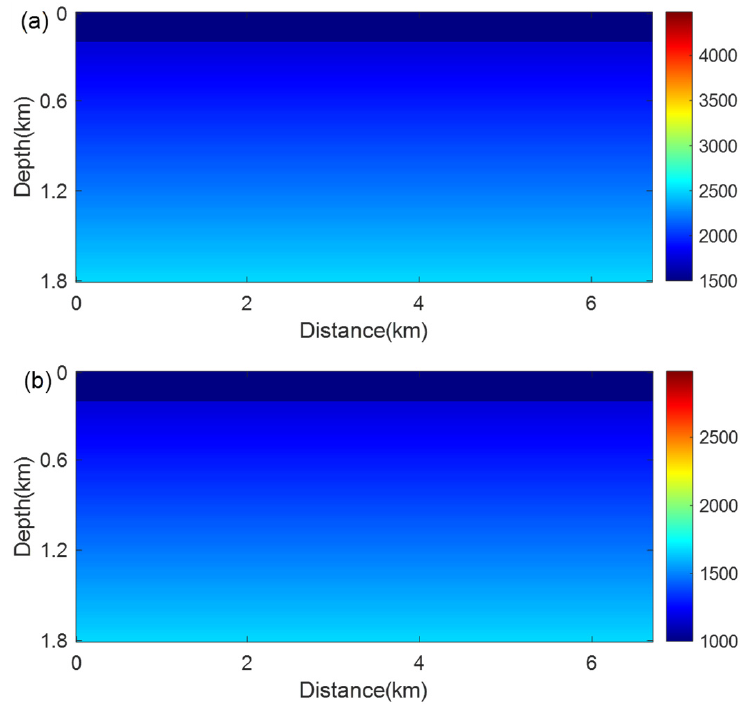
Figure 4. Initial velocity model. ( a ) Initial Vp model; ( b ) Initial Vs model.